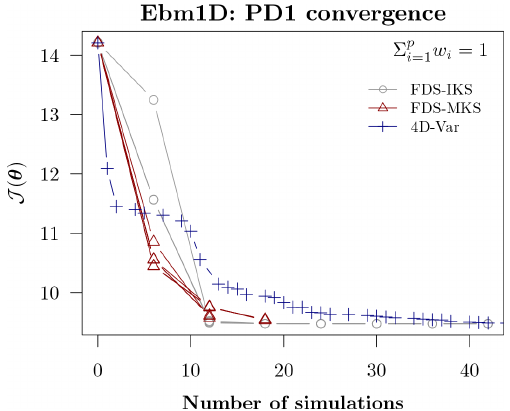
Figure 2. Ebm1D experiment. Convergence as a function of the w i = 1). Each it- number of simulations for the scenario PD1 ( (cid:54) p i = 1 eration of the evaluated finite-difference schemes requires six sim- ulations (background plus number of perturbations, with one per- turbation per parameter). Two-step and three-step FDS-MKS are included. Each FDS scheme includes the convergence for the three perturbation tests (details in